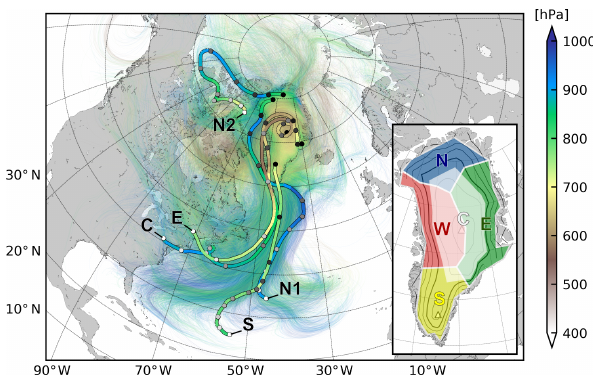
Figure 2. All extended (10d) melt trajectories of EV69 colored ac- cording to their pressure. Five example trajectories represent char- acteristic airstreams (S, C, E, N1, N2), shown in thicker lines with one circle per day colored from white ( t = − 240h) to black ( t = 0h). The subfigure map shows characteristic regions of the GrIS: south (S), west (W), north (N), east (E), and central plateau (C).